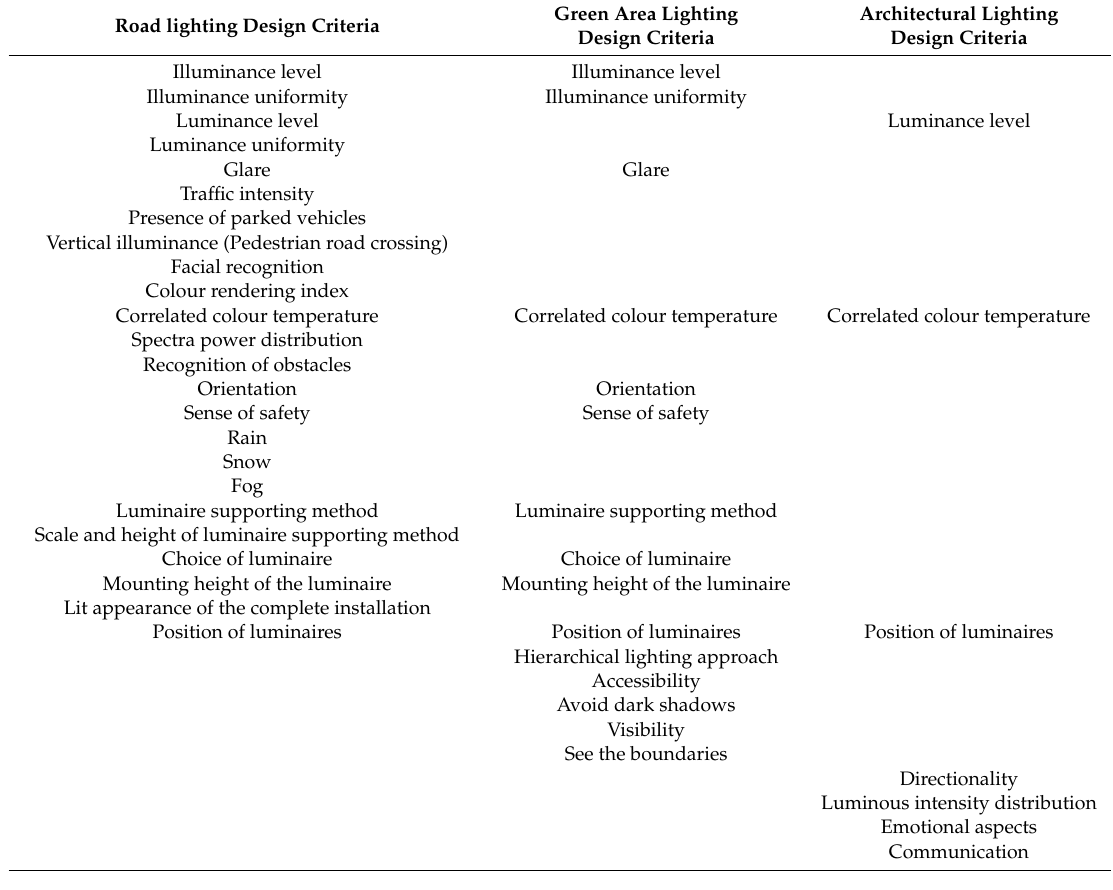
Table 1. Objective and subjective criteria used to design the lighting systems upon varying the area of the